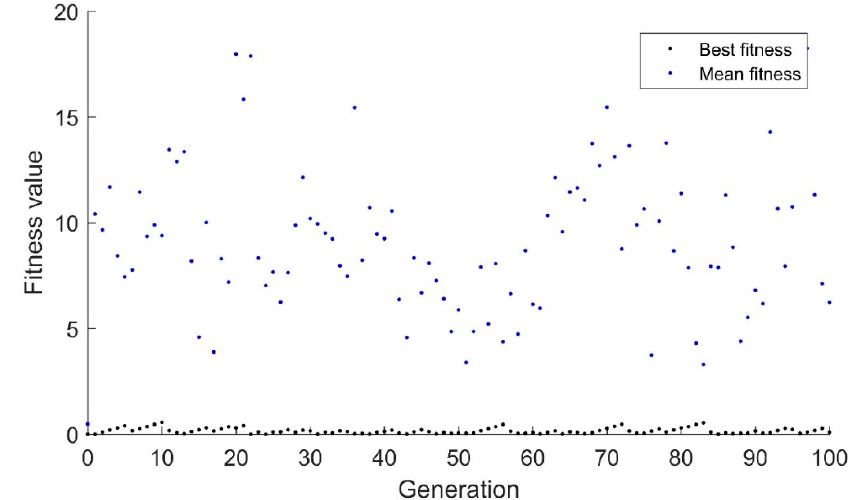
Figure 3. A real-valued genetic algorithm using a normally distributed mutation with standard deviation of 0.1 responding to a moving goal after initial convergence.